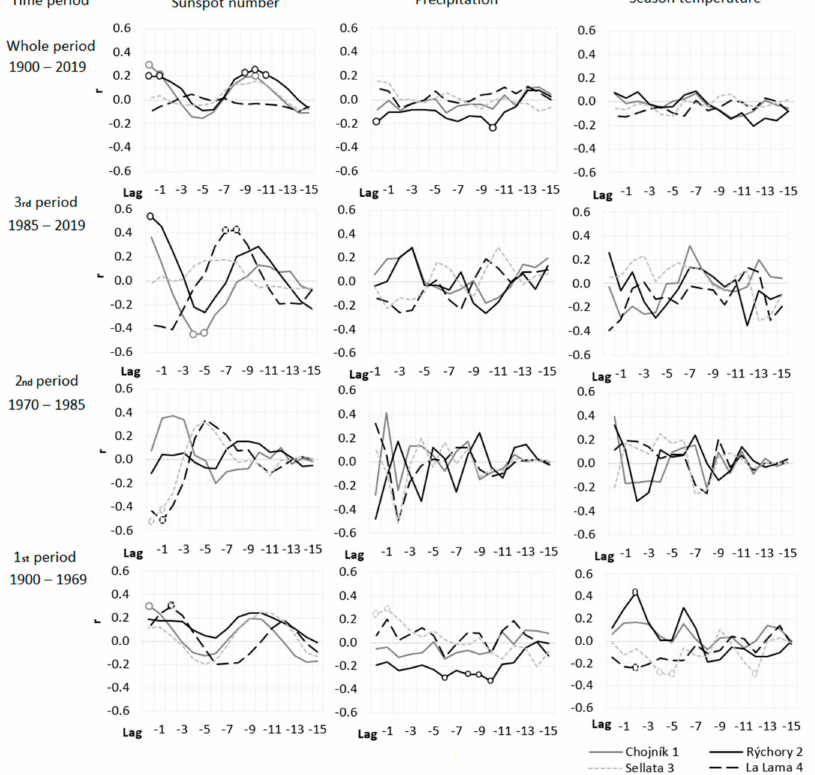
Figure 3. Cross-correlation of ring width index with sunspot number, precipitation and temperature in the three time periods and the whole time period. Values are significant at p < 0.05 and marked with a circle. Lag: year (Lag − 1 is the correlation of the 1 preceding